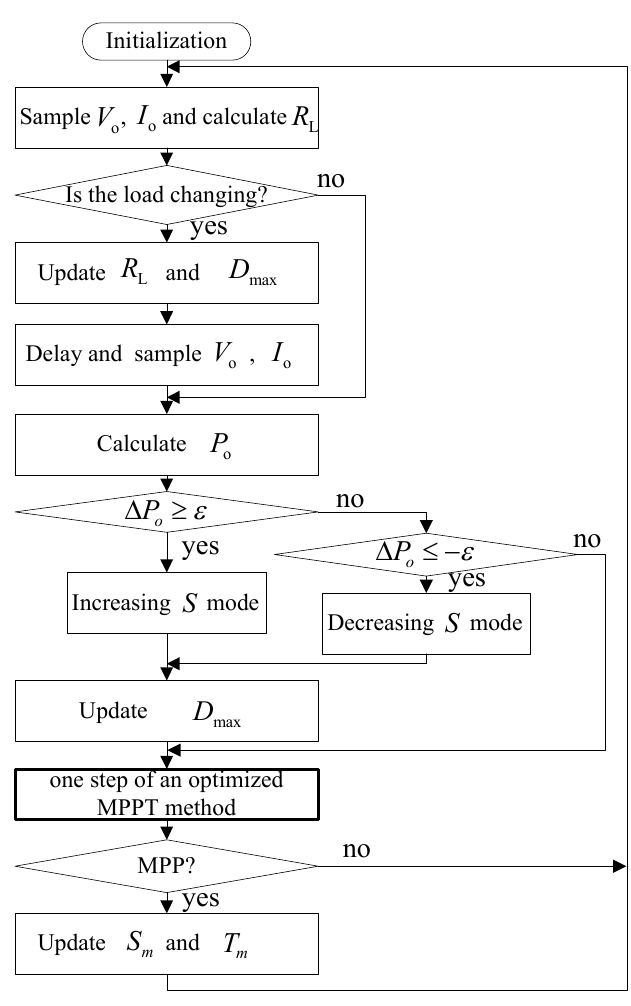
Figure 11. Flow chart of the VWPOS.